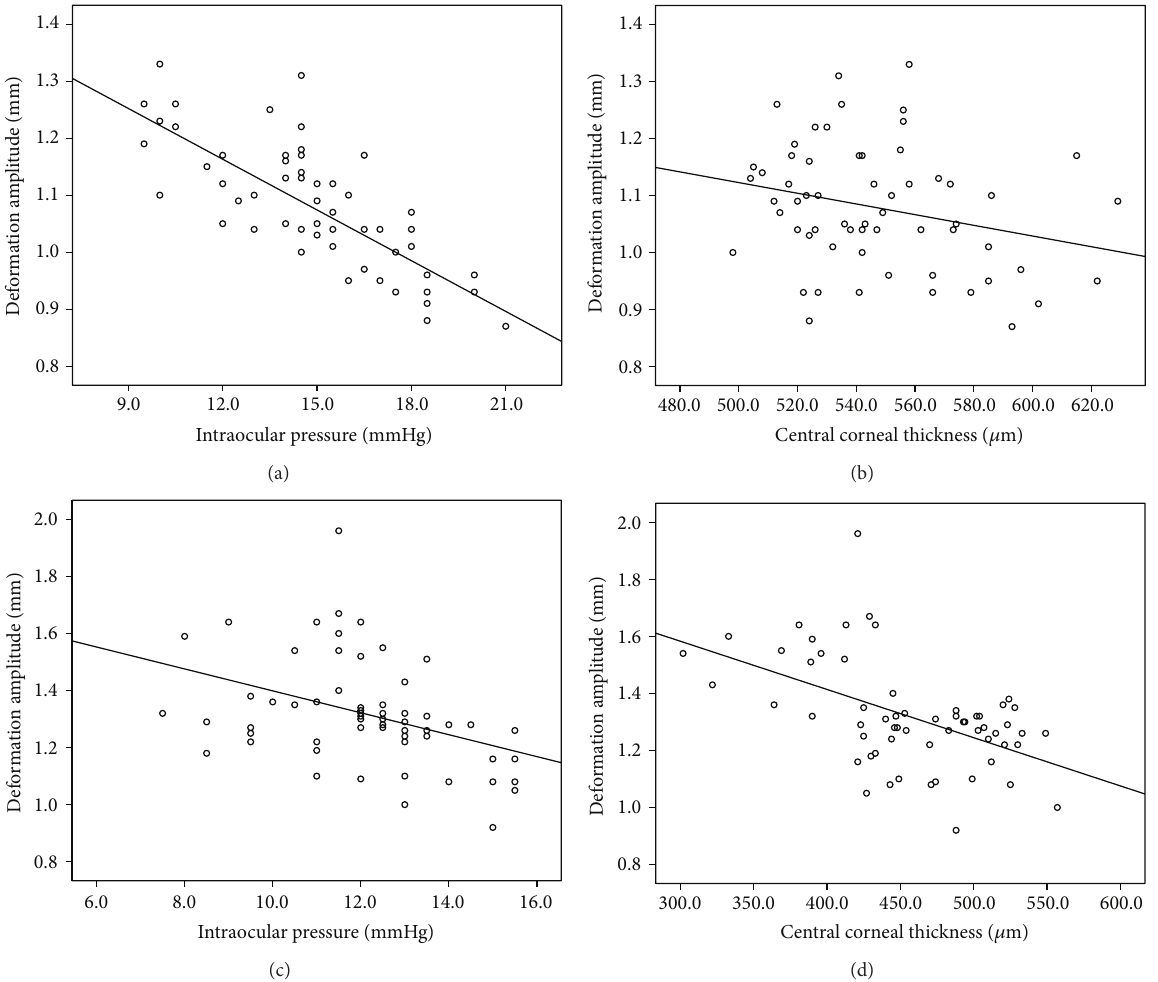
Figure 5: Scatterplots DA versus IOP-GAT (a) and CCT (b) in normal eyes and scatterplots of DA versus IOP-GAT (c) and CCT (d) in keratoconic